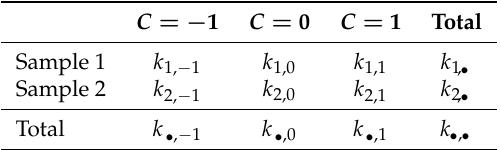
Table 3. Observed numbers in given sample and